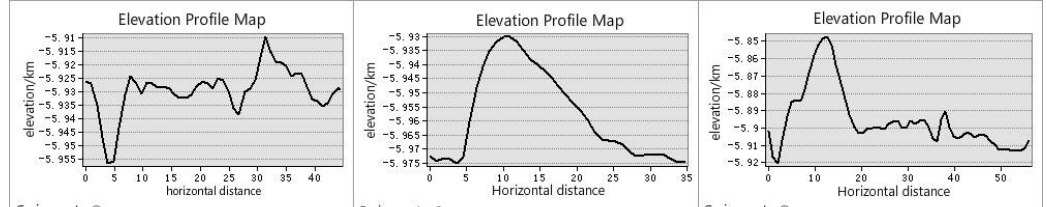
Figure10. Vertical structure of the cruise route